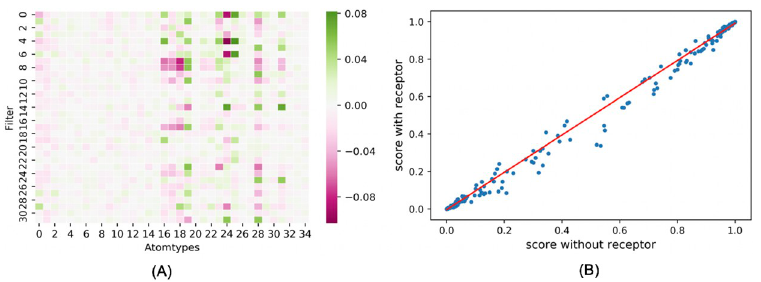
Fig 6. The weights and predicted ligand scores of the AA2AR receptor-ligand CNN model. (A) The average weight put on each atom type in the 32 filters from the first convolutional layer of the AA2AR receptor-ligand CNN model; atom types 0–15 are from the receptor, and atom types 16–34 are from the ligand. (B) Correlation between scores predicted by the AA2AR receptor-ligand CNN model on ligands with vs. without receptor information provided. R 2 =